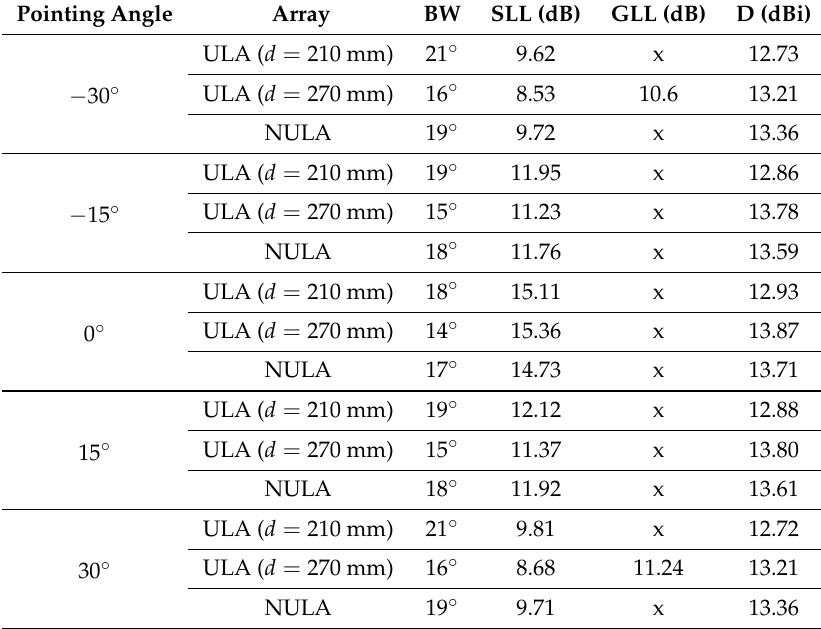
Table 4. Main characteristics of the azimuth plane radiation patterns generated with maximum directivity weighting vectors of the ULAs with inter-element spacings of 210 mm and 270 mm and the NULA designed in Section 3.2, for N = 5 commercial antennas. The considered steering angles are φ = [ − 30, − 15,0,15,30 ] ◦